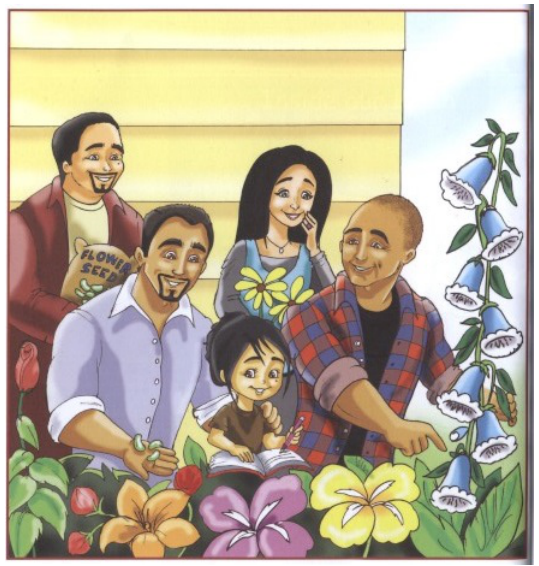
Figure 13. Queer kinship as an extension of reproductive family.